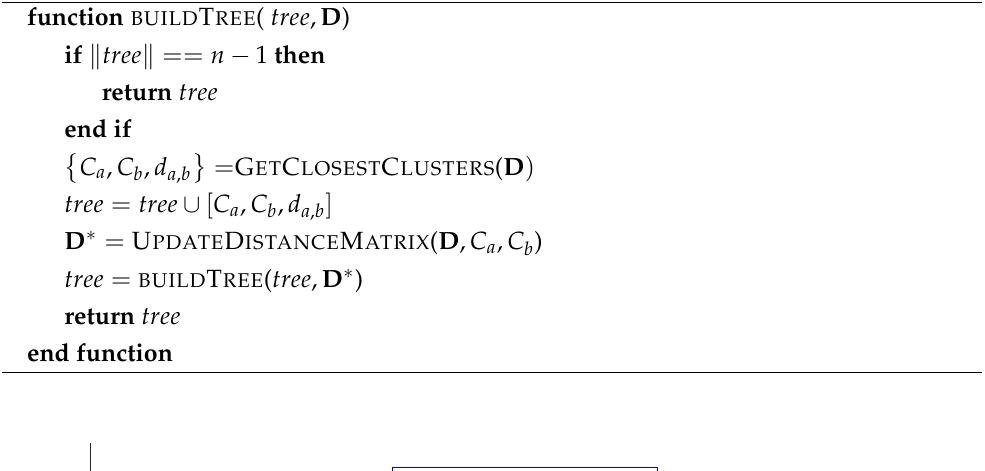
Algorithm 1 Agglomerative clustering algorithm